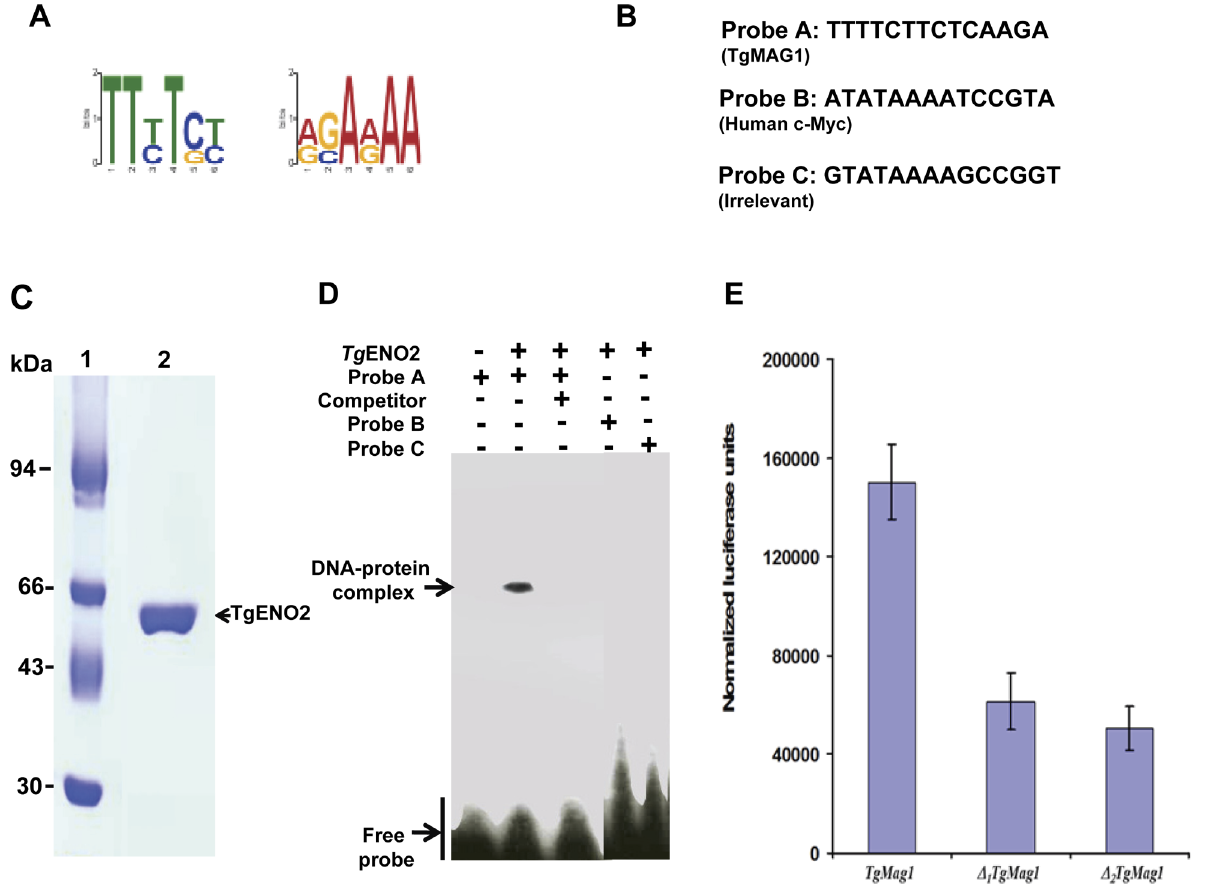
Figure 4. Role of the TTTTCT motif in specific TgENO2-DNA interactions and promoter activity. A) The TTTTCT motif was identified in the putative gene promoters targeted by nuclear TgENO2 using ChIP-Seq (Table S4) and the MEME bioinformatics tool (a motif-based sequence analysis tool). B) Nucleotide sequences of probes corresponding to the TTTTCT motif in the promoter of TgMag1 gene, the TATA box from human c-Myc gene, and a non-relevant motif used as a negative control. C) Expression and purification of recombinant TgENO2 fused to His-Tag. D)